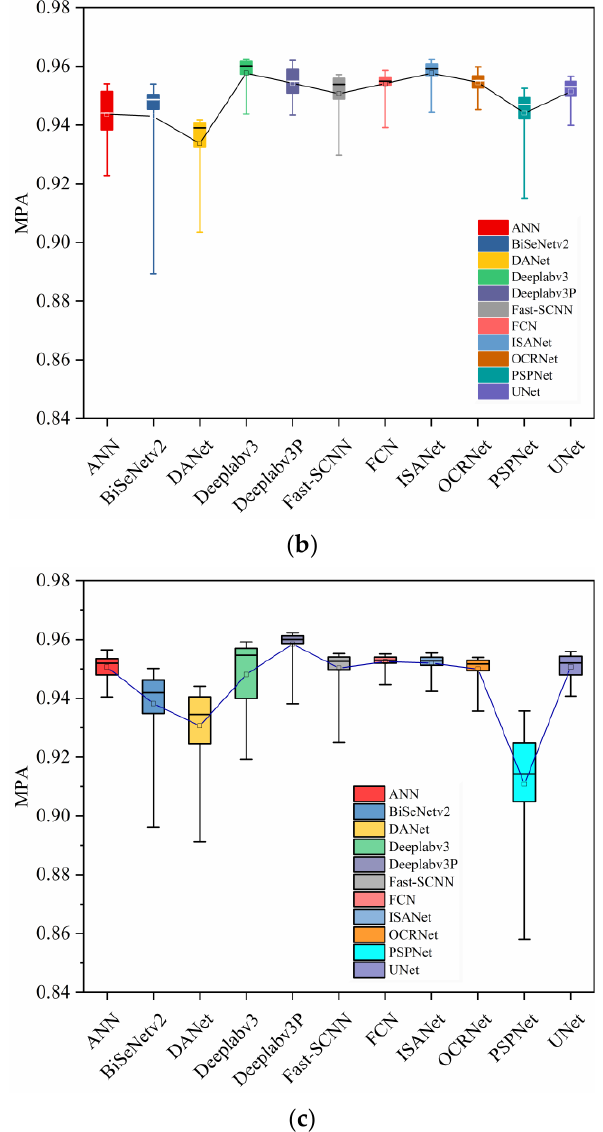
Figure 14. MPA values of 11 models on the three datasets: ( a ) left eye, ( b ) right eye, and ( c ) left and right eyes.